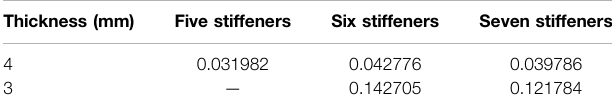
FIGURE 15 | The total deformation distribution.